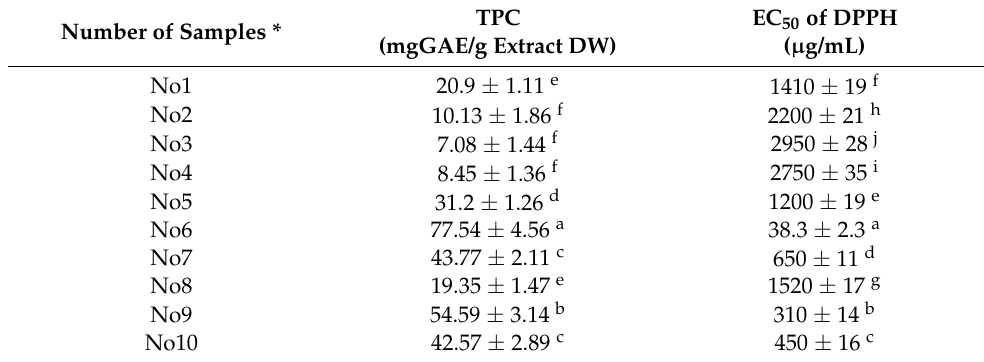
Table 1. Total polyphenols content (TPC) and IC 50 of DPPH • of the examined extracts’ powders. TPC EC 50 of Number of Samples * (mgGAE/g Extract DW)